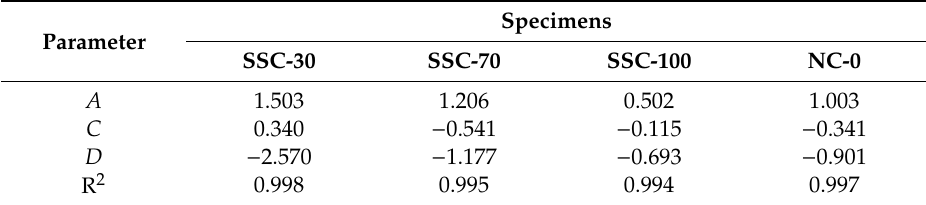
Table 4. The fitting results of failure criterion model for